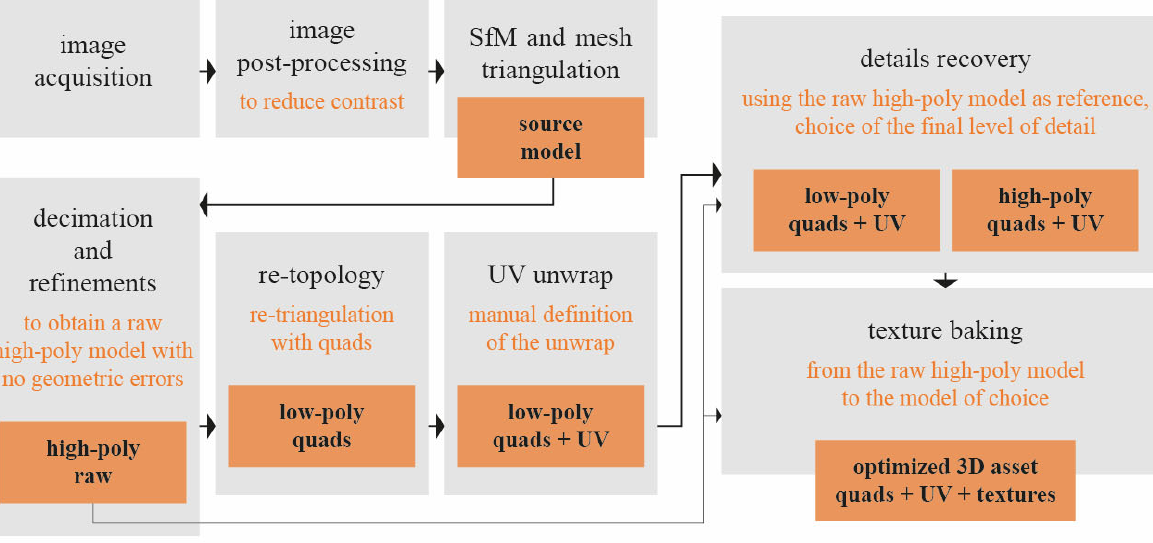
Figure 5. Scheme of the proposed workflow from image acquisition to 3D asset processing.